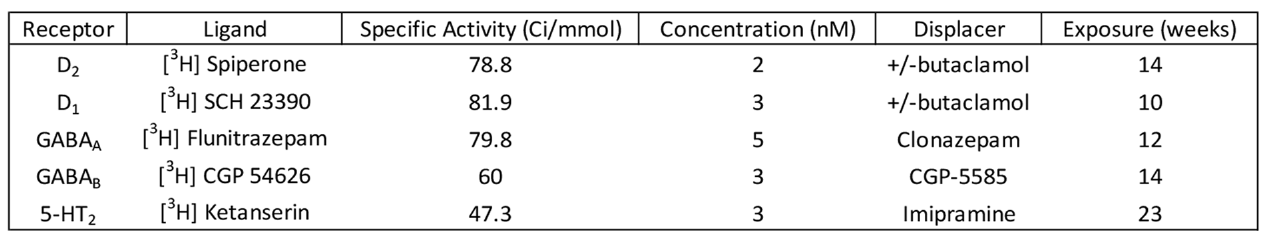
TABLE 2 | Ligand binding